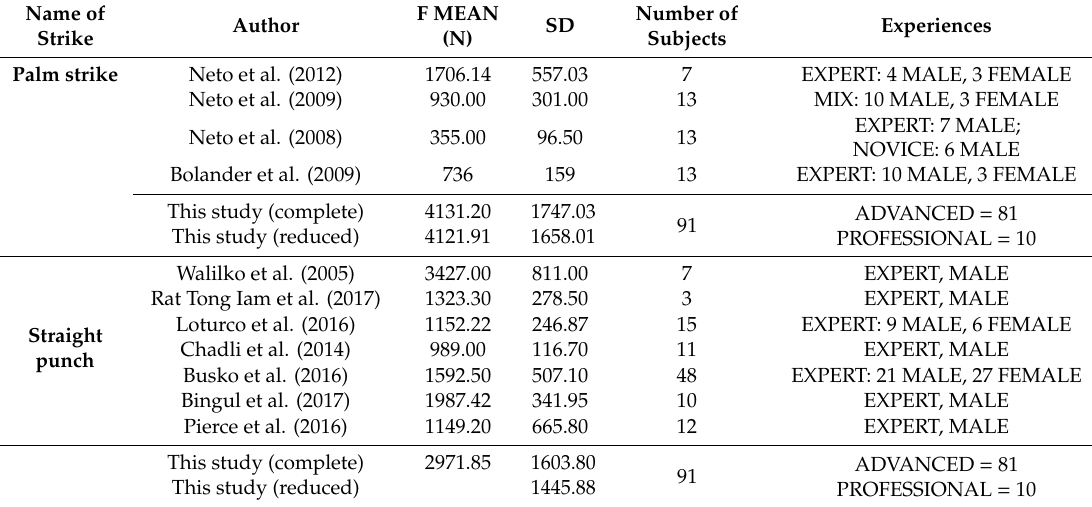
Table A2. Direct and palm strike peak force mean and standard